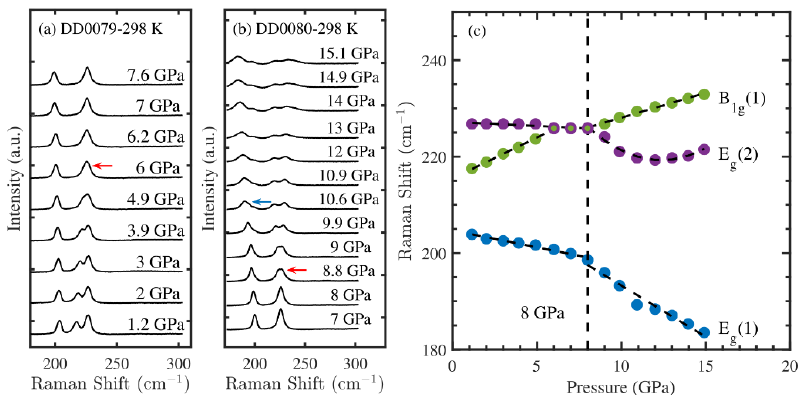
Figure 3. The characteristics of zircon Raman spectra at different pressures for ( a ) DD0079 and ( b ) DD0080. The red arrow in ( a ) represents the merger of the B 1g (1) and E g (2) modes into one peak, which splits into two peaks, as shown by the red arrow in ( b ). The blue arrow in ( b ) represents the split of the E g (1) mode into two peaks. ( c ) The Raman shift of the E g (1), B 1g (1), and E g (2) zircon modes as a function of pressure for DD0079 and DD0080. The vertical dashed lines correspond to the abrupt changes of 𝑑𝜔 / 𝑑𝑃 of the E g (1) and E g (2) modes.